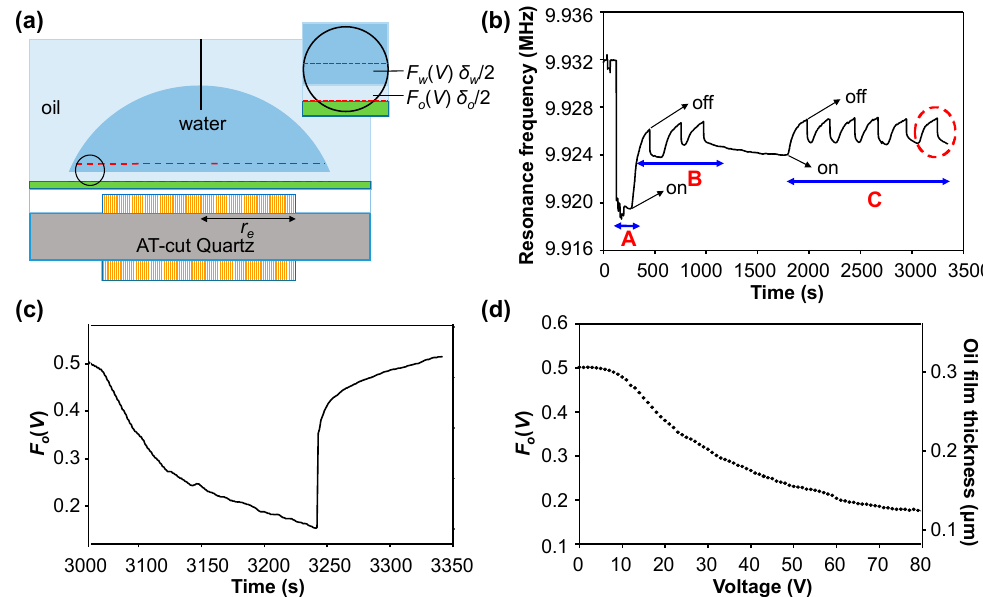
Figure 3. Evaluation of the oil film between the water and a QCM coated with dielectric and hydrophobic layers. ( a ) Illustration depicting a QCM surface completely covered with water and the assumption of an oil film F o ( V ) δ o /2 present under the water droplet. ( b ) The application of an AC voltage (1 kHz, 95 V) caused a transiently increased resonance frequency indicated by B. After the transient state, the voltage on-off generated a stable frequency shift. ( c ) F o ( V ) of the oil film in a cycle (dashed circle in ( b )) calculated with Equation (10). ( d ) F o ( V ) and the thickness of the oil film as modulated on application of a